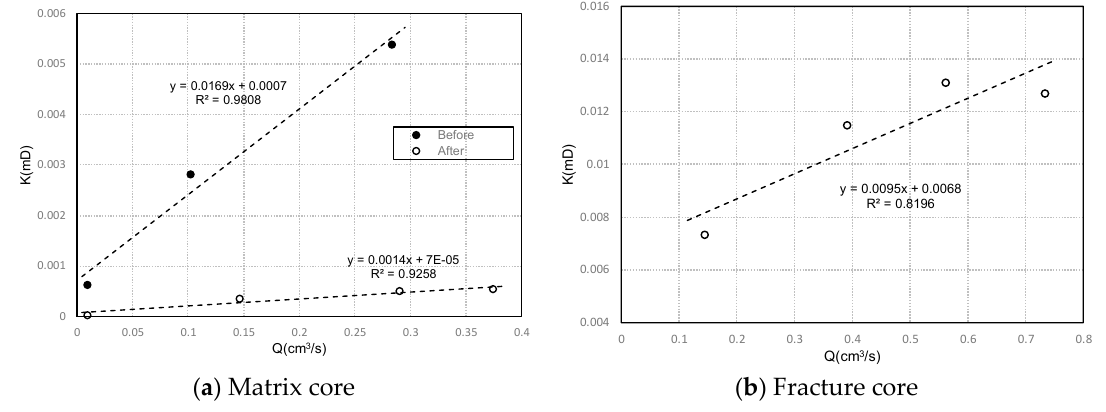
Figure 8. Comparison of core permeability before and after water injection.